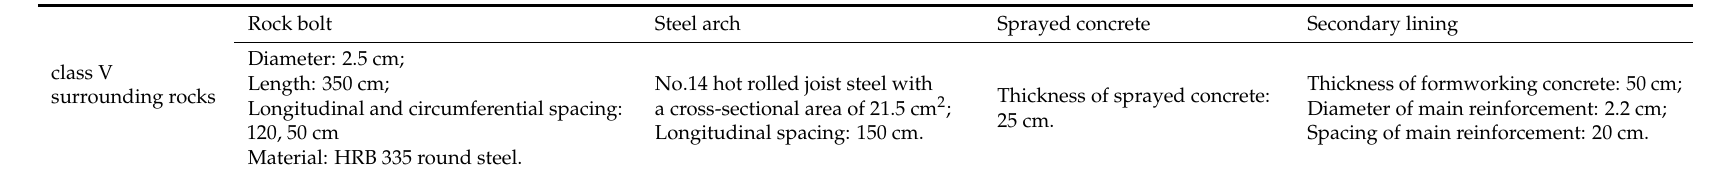
Table 3. Detailed parameters of primary and secondary supports in class V surrounding